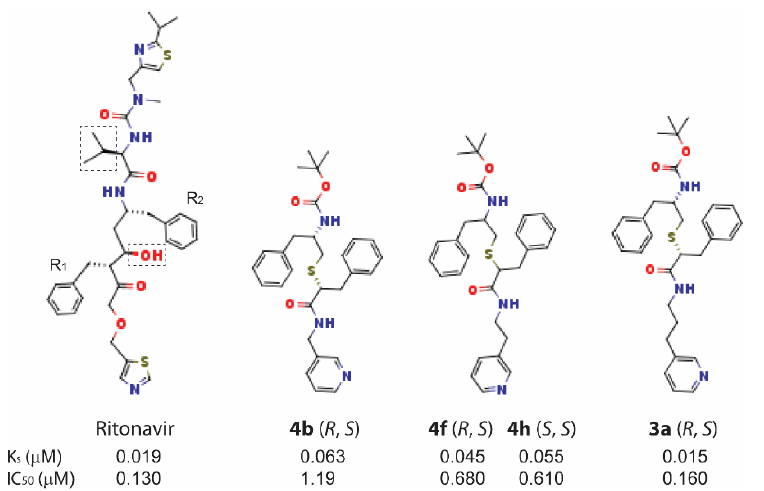
Figure 1. Chemical structures of ritonavir and previously reported analogues from series III ( 4b , 4f , and 4h ) [16] and V ( 3a ) [17] that were used for structural and functional comparison in this study. The R 1 - and R 2 -phenyl side-groups are indicated. If the central hydroxyl group of ritonavir is removed, the phenyl side-groups would be in the R / R configuration. The listed IC 50 values were measured for the BFC debenzylation activity of CYP3A4 using the same method as in this study. In cobicistat, a close derivative of ritonavir, there are only two modifications (boxed): the backbone hydroxyl group is removed, and the valine chain in the end-moiety is replaced with the bulkier morpholine ring.